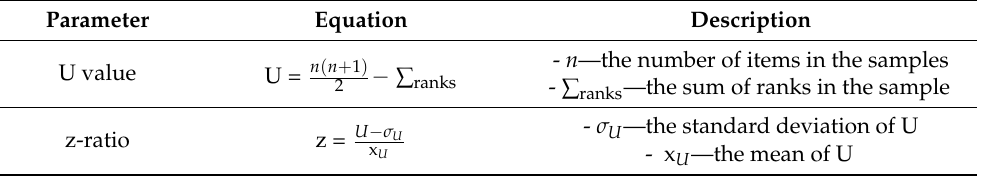
Table 1. The method of calculating parameters in the Mann-Whitney U Test.